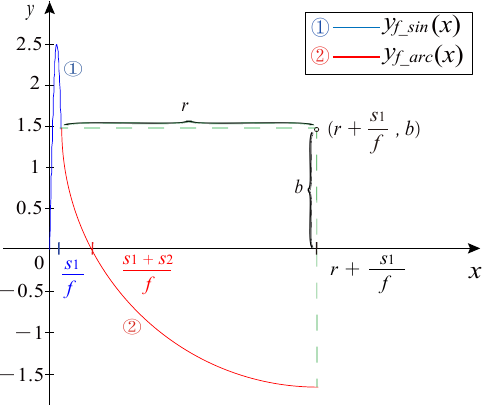
where y b _ sin ( x ) represents the behind sinusoidal part of the missing teeth signal. The posterior part of the missing tooth waveform is generated by Equations (14) and (15). In Figure 10, circle 1 in red represents the arc portion, and circle 2 in blue represents the sinusoidal portion.